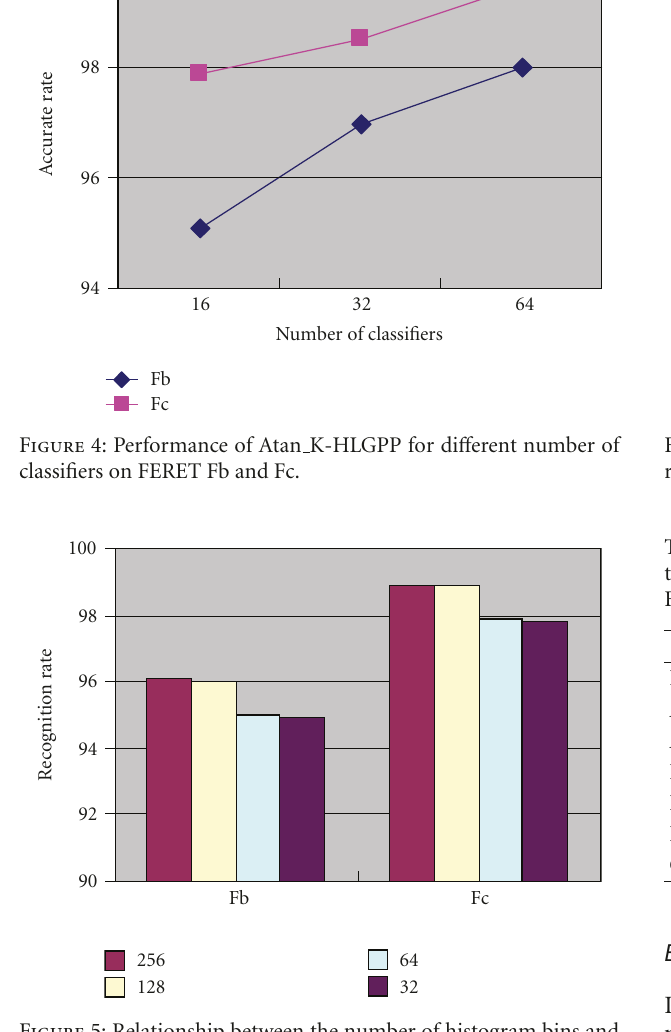
Figure 5: Relationship between the number of histogram bins and recognition rate (direct Atan HGLXP).